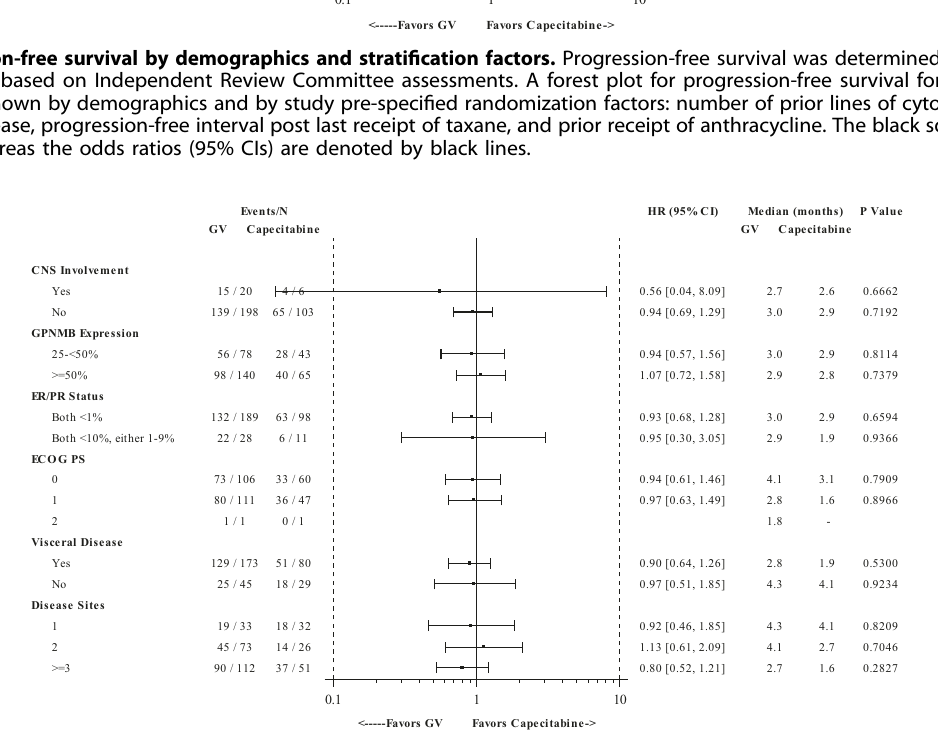
GV (Celldex Therapeutics, Inc., Fall River, MA) was administered every 3 weeks as a 90-minute intravenous infusion, starting dose of 1.88 mg/kg. Dose reductions to 1.3 and 1.0 mg/kg were allowed for toxicity.